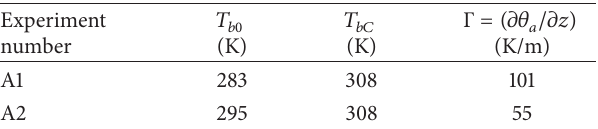
Table 1: Convective boundary layer experimental parameters. Details of initial conditions for experiments A1 and A2. 𝑇 𝑏0 is the temperature at the bottom before heating starts, 𝑇 𝑏𝐶 is the final heating temperature, and Γ is the vertical component of the temperature gradient. The duration of the experiments is roughly 2100